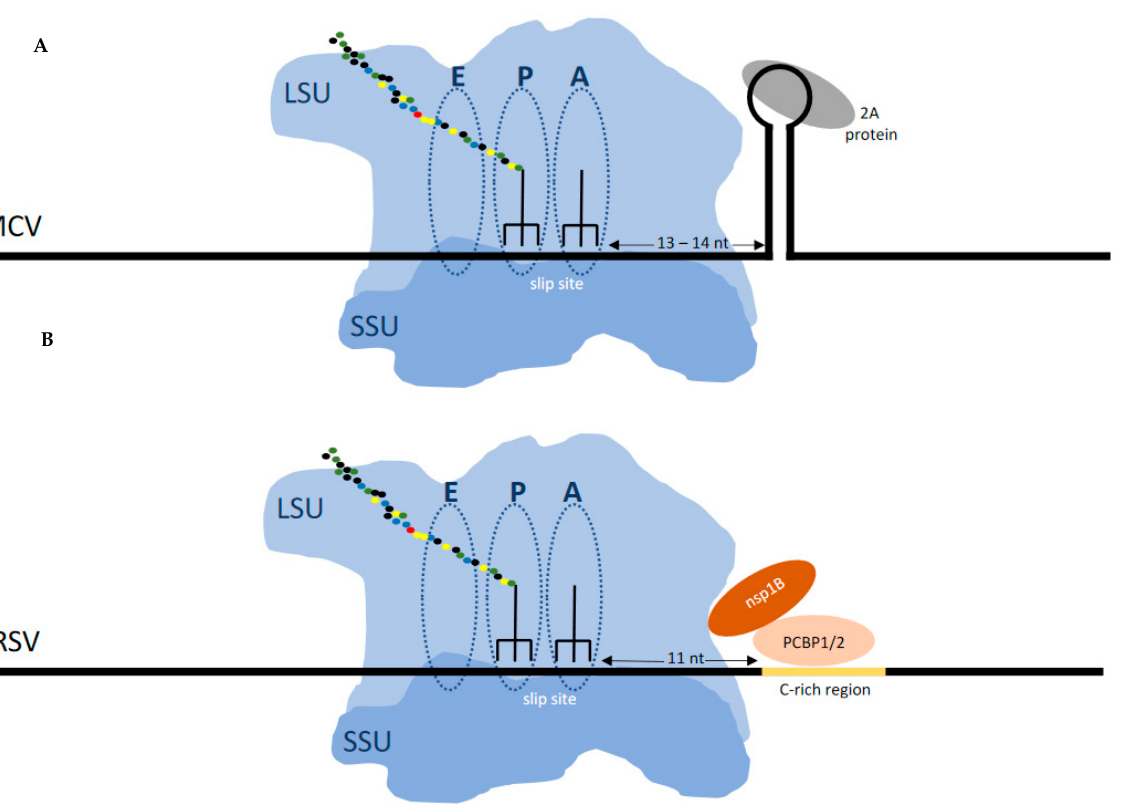
Figure 4. ( A ) Frameshifting in EMCV (and TMEV) is stimulated by a protein:RNA complex positioned at the leading edge of the ribosome when the decoding center is on the shift site. The viral encoded 2A protein, which is encoded 5 ′ of the shift site, binds to the 3‘ stem loop to stimulate frameshifting. ( B ) Frameshifting in PRRSV is stimulated by a protein:RNA complex that requires dimerization of the virally encoded nsp1B protein and the chromosomally encoded polyC binding protein which bind to the 3‘ stem loop to stimulate frameshifting.